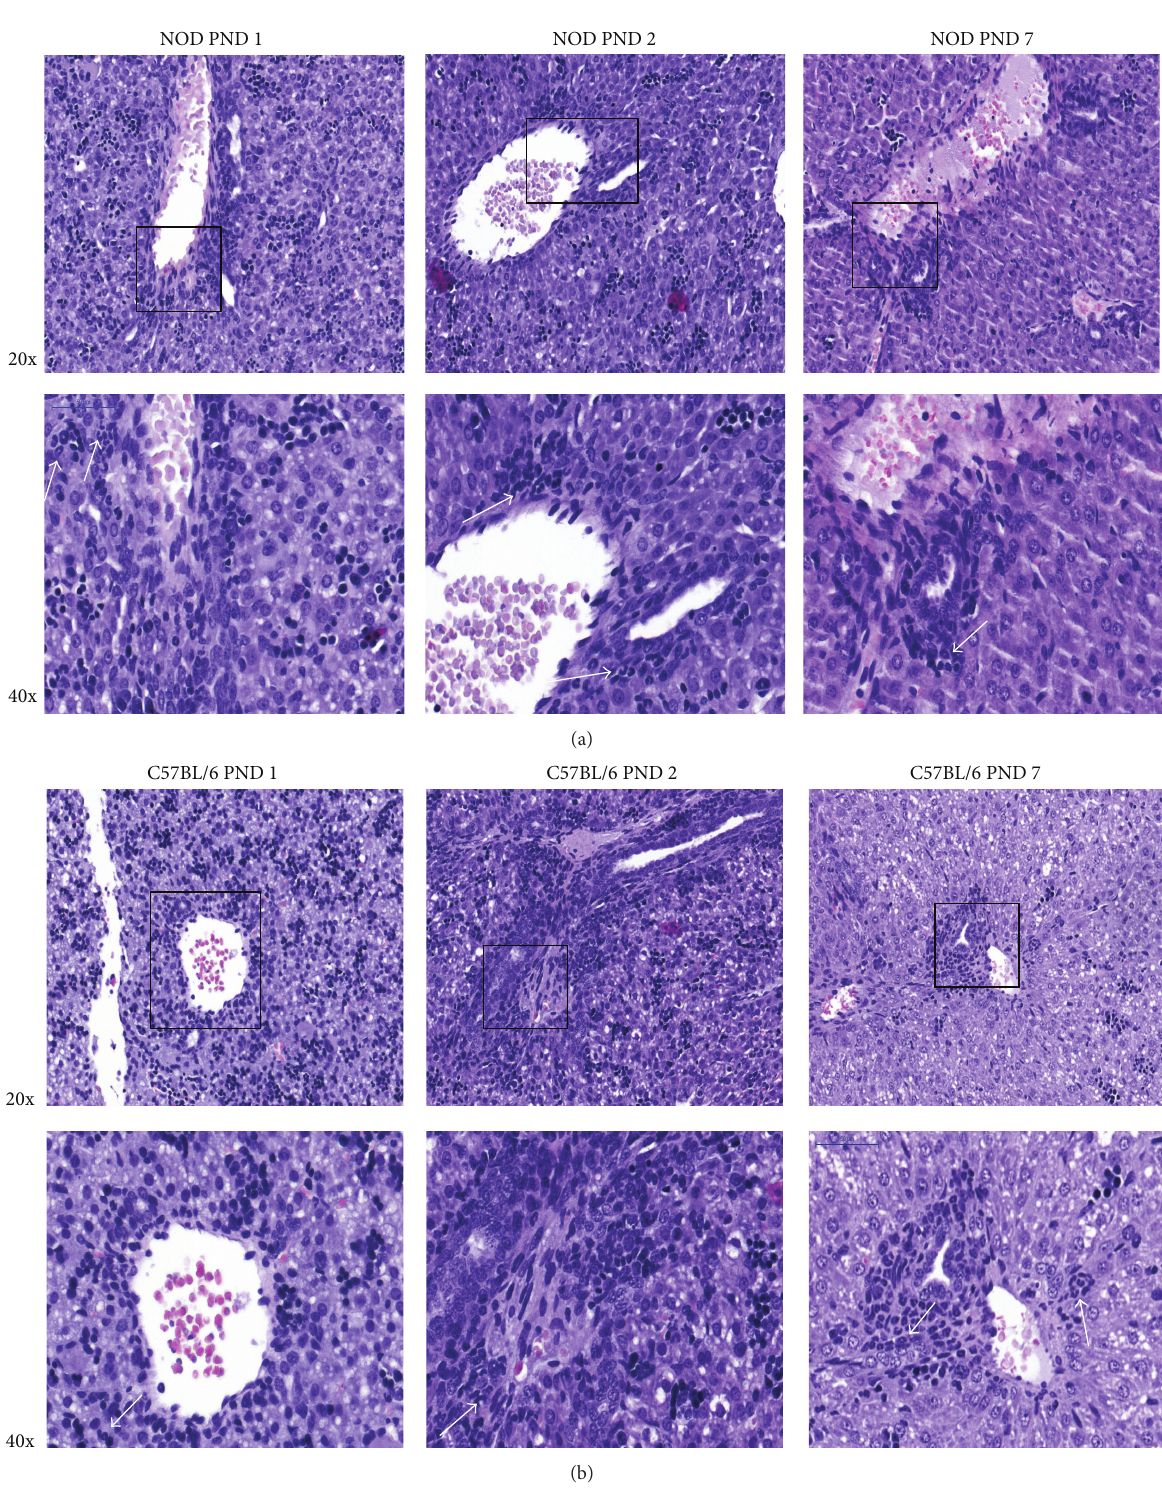
Figure 3: In NOD mice the granulocytic phenotype of cells accumulated around the hepatic portal veins. Hematoxylin and eosin (HE) staining of neonatal PND 1–7 liver tissue sections from NOD (a) and C57BL/6 mice